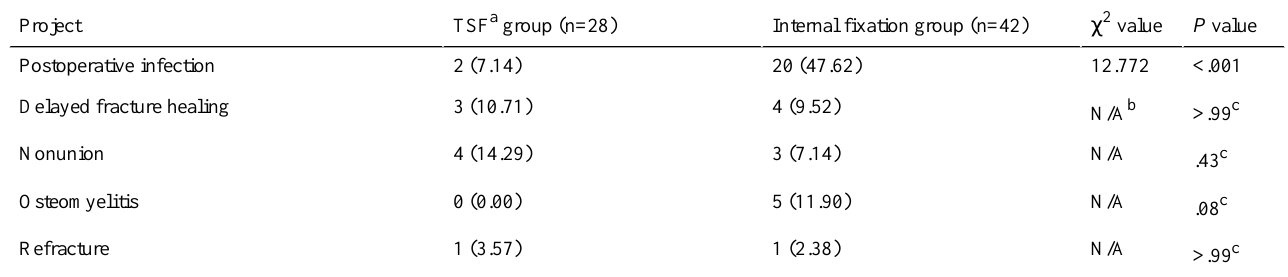
Table 2. Comparison of postoperative complications between the two